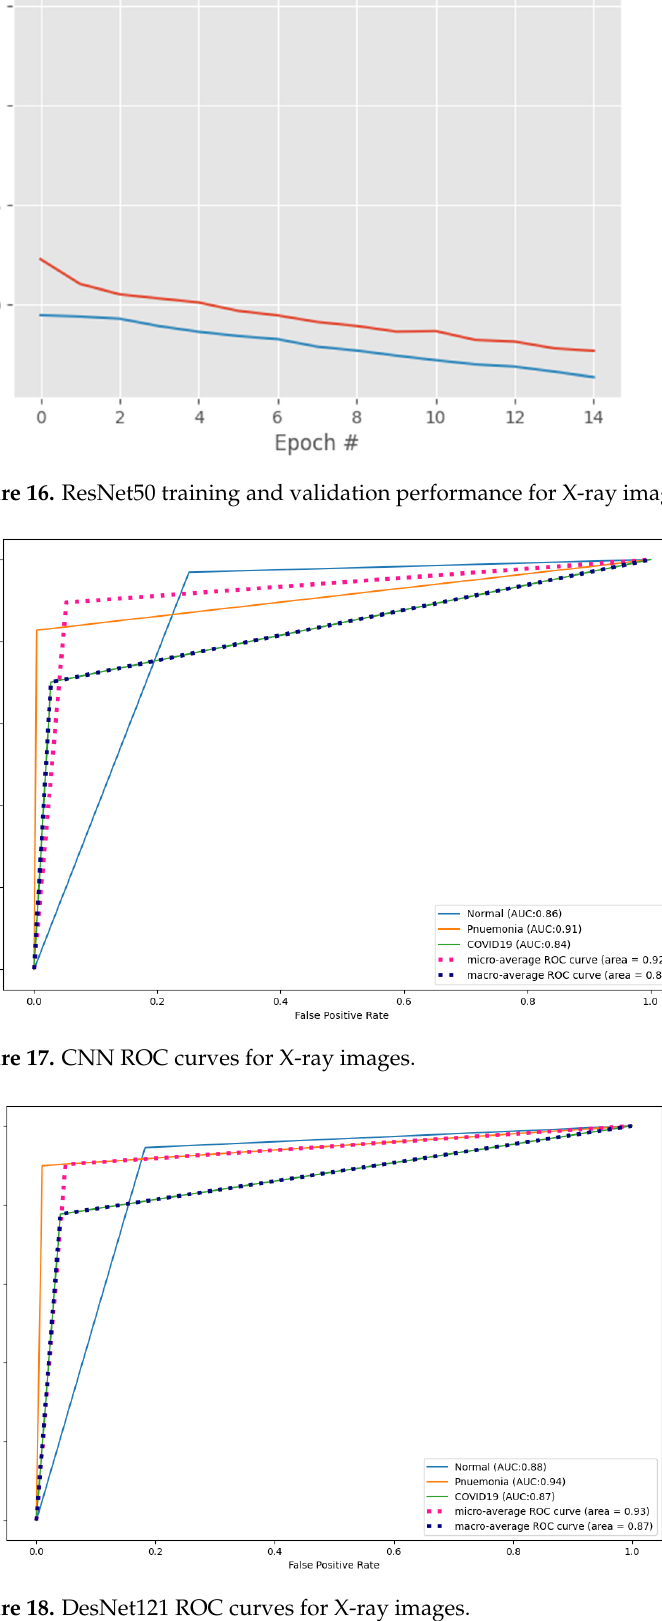
Figure 19. ResNet50 ROC curves for X-ray images. 4.6. Performance of CapsNetCovid on Augmented Dataset for Multi ‐ Class Classi fi cation As aforementioned, the proposed technique was evaluated on four augmented X-ray datasets containing 15,153 randomly fl ipped, randomly rotated, and randomly shifted X- ray images. The results are reported in Tables 11–15. As shown, the performance of Cap- sNetCovid decreased when evaluated on the augmented images. This is obviously be- cause the model was not exposed to any of the augmented images during training. Cap- sNetCovid was anticipated to successfully recognize a larger percentage of the augmented version of the images it was trained on. However, as shown in the results, that was not the case. This shows that the robustness of CapsNet to a ffi ne transformations requires im- provement, especially for multi-class classi fi cation. This is an opportunity for future re- search. As shown in Tables 11–15, the performance of CapsNetCovid on randomly fl ipped, randomly rotated, and randomly shifted images varies. It achieved a higher classi fi cation accuracy for randomly fl ipped and randomly rotated images. This shows that the Cap- sNet is more resistant to randomly fl ipped and rotated images compared to randomly shifted images. CapsNetCovid also produced higher AUC score for randomly fl ipped and rotated images. This shows that it correctly predicted more randomly fl ipped COVID-19 and pneumonia images compared to normal images. The results also show that Cap- sNetCovid performed be tt er on images that are randomly rotated by 45 degrees compared